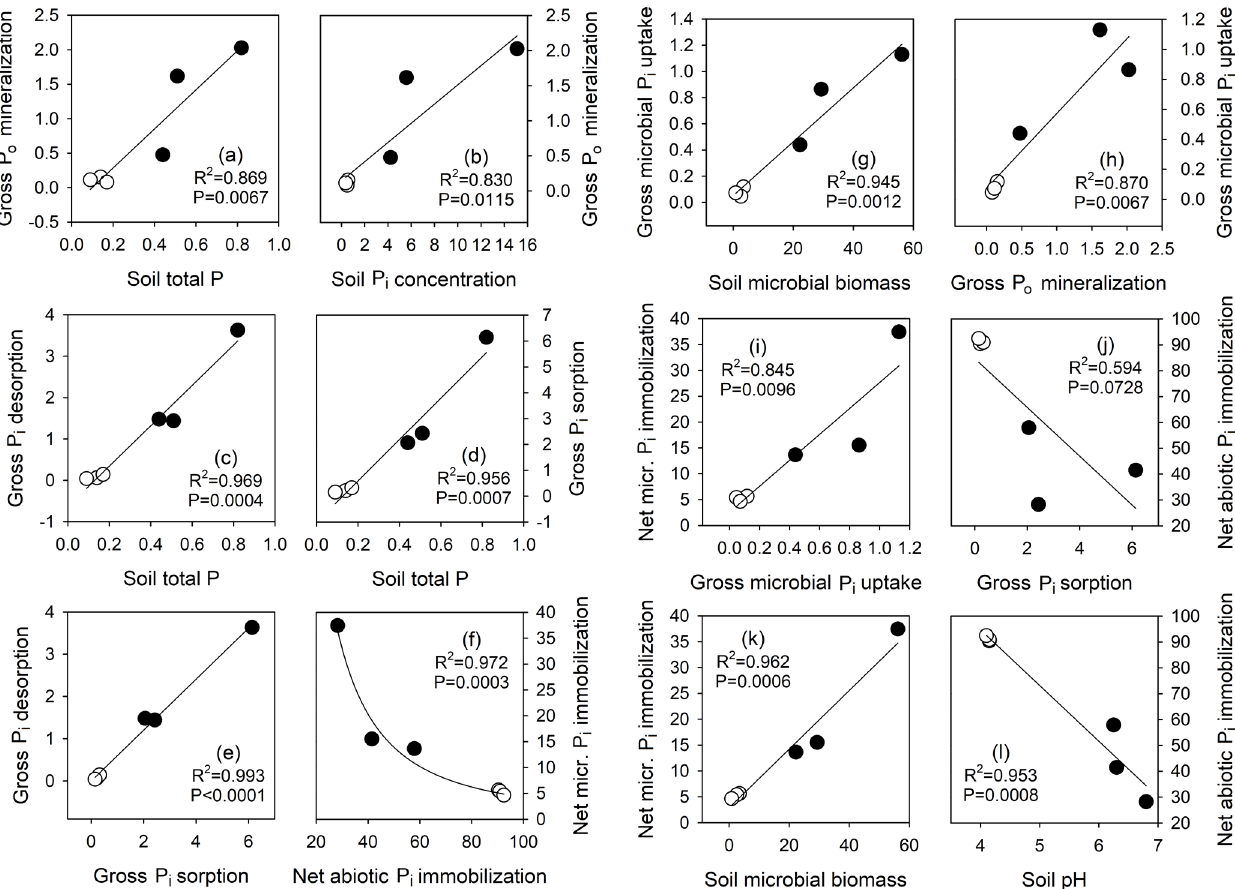
Figure 8. Relationship between selected soil physicochemical parameters, net abiotic and microbial immobilization fluxes, gross P i influx rates by biological processes (gross P o mineralization) and abiotic processes (gross P i desorption), and gross P i efflux rates by biological processes (gross microbial P i uptake) and abiotic processes (gross P i sorption). Regression lines are for linear or power function fits, and P and R 2 values for these are shown. Open circles ( ◦ ) depict tropical forest soils, and closed circles ( • ) depict temperate grassland soils. Units are provided in Table 2 for soil physicochemical parameters and phosphomonoesterase, and are the percentage (%) of added tracer for net processes, and micrograms of phosphorus per gram soil dry weight per day (µgPg − 1 soildwd − 1 ) for gross process